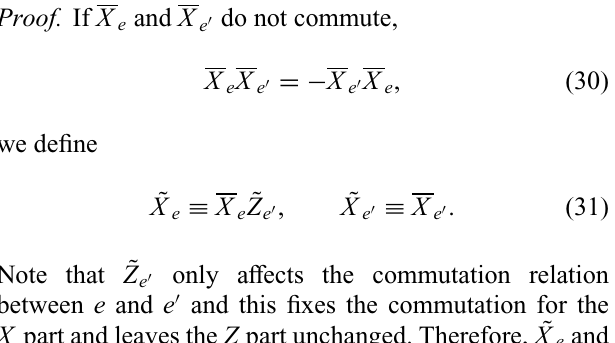
FIG. 10. The (potential) flippers. For G (cid:7) on the gray face a , a its flipper is the product of X connecting two gray faces on its right column, shown by the green operator. For G b on the white face, its potential flipper is the product of X connecting to a gray face below, shown by the blue operator. This potential flipper may anticommute with G (cid:7) on a gray face, which can be fixed on a horizontal edge by attaching the flipper for this G (cid:7) . For U e 1 , which flips exactly one U e and e 1 , the potential flipper is Z e 1 on white and gray faces. anticommutes with some G f and G (cid:7) f This can be fixed by attaching the flippers for these G f and G (cid:7) f to the potential flipper of U e 1